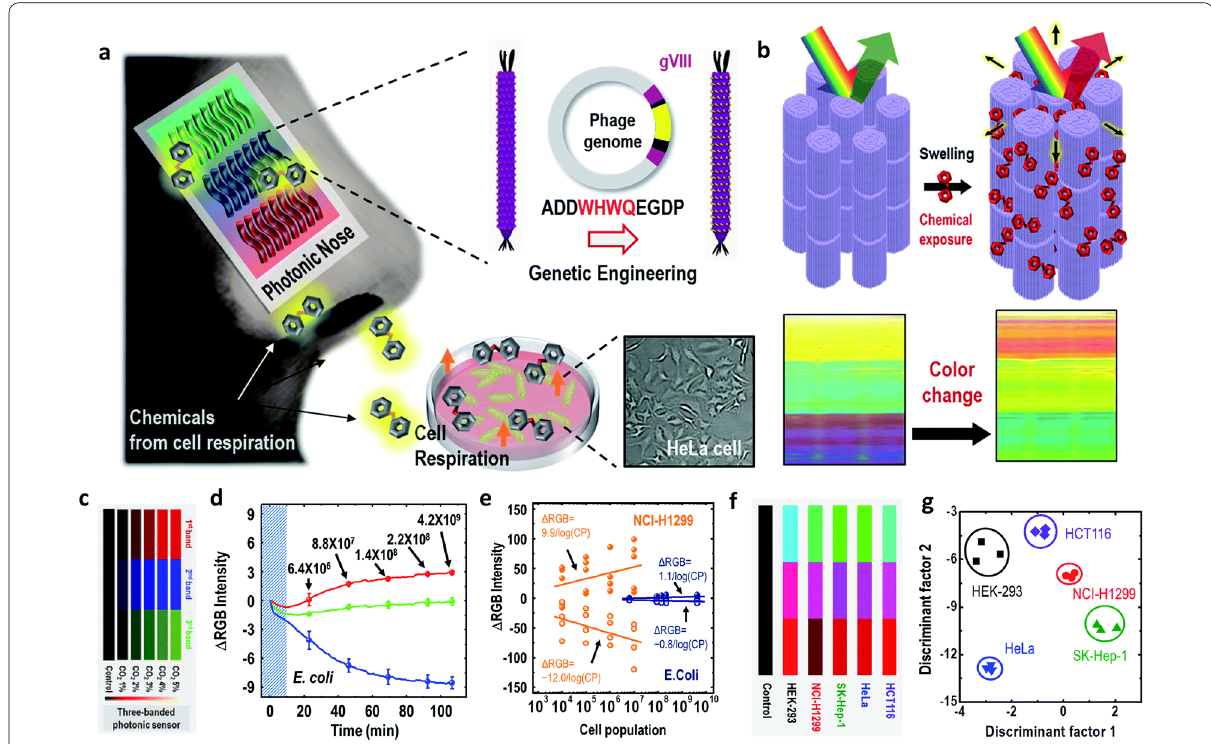
Fig. 6 M13 bacteriophage based photonic nose for differential cell recognition. a Specific odorants produced by cell breathe. b Swelling of M13 bacteriophage bundle responding to vapor phase chemicals resulting in scattering colour change. c colour fingerprints from the M13 bacteriophage‑based photonic nose on exposure to different carbon dioxide concentrations. d Real‑time RGB intensity profile for E. coli incubated with the photonic nose. e RGB intensity change from both E. coli and NCI‑H1299 cells as a function of different cell populations. f RGB colour patterns after exposure to the respiration of different cell types. g LDA plot of the colour changes resulting from exposure to HEK‑293, NCI‑H1299, SKHep‑1, HeLa and HCT116 cells ( a – g Reproduced from Ref. [95]. Copyright 2017, The Royal Society of